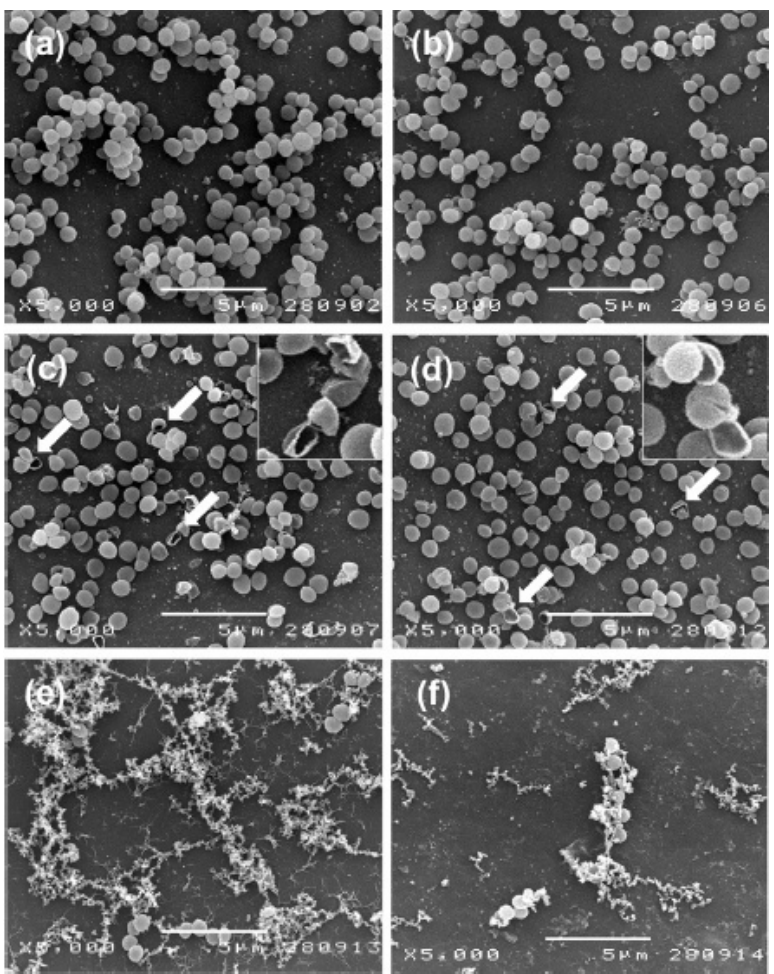
Figure 3. SEM micrographs of chitosan ( a ) and x BZDCHT films: 0.4BZDCHT ( b ); 0.8BZDCHT ( c ); 1.2BZDCHT ( d ); 1.6BZDCHT ( e ); and 2.0BZDCHT ( f ) after